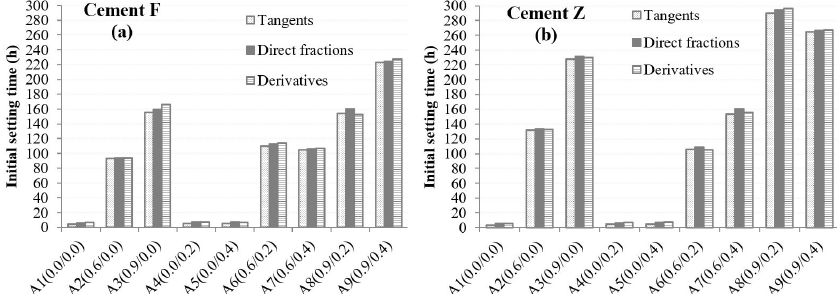
Figure 9. Initial setting times obtained by different methods for mortars with cements F and